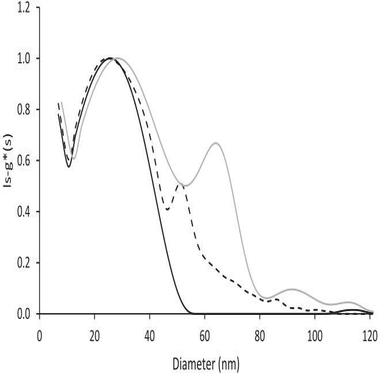
Size distribution measured with AUC of liposomes (black line) and liposomes with quercetin (dotted black line) calculated from the absorptionbased measurement at 250 nm. The grey line indicates the distribution of loaded liposomes with the adsorption-based measurement at 370 nm.